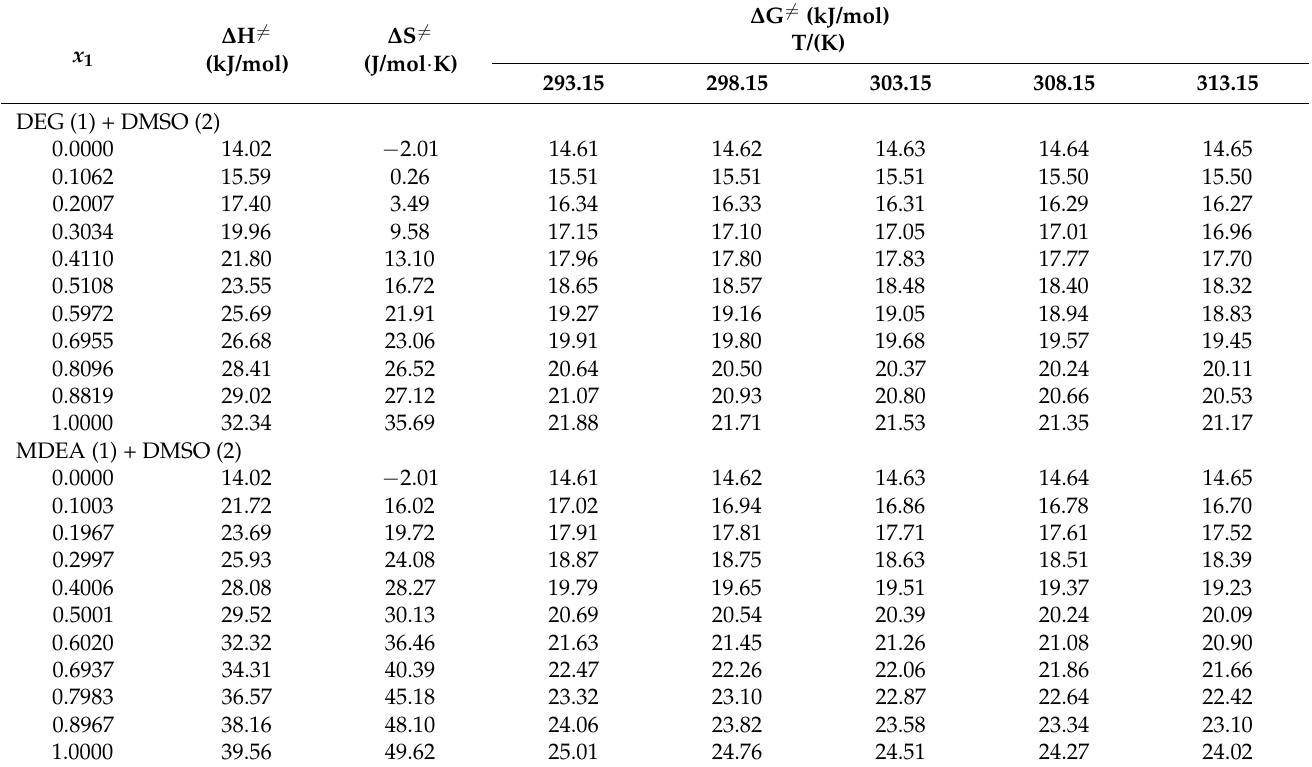
Table 5. Values of ∆ G (cid:54) = , ∆ H (cid:54) = , ∆ S (cid:54) = for the binary